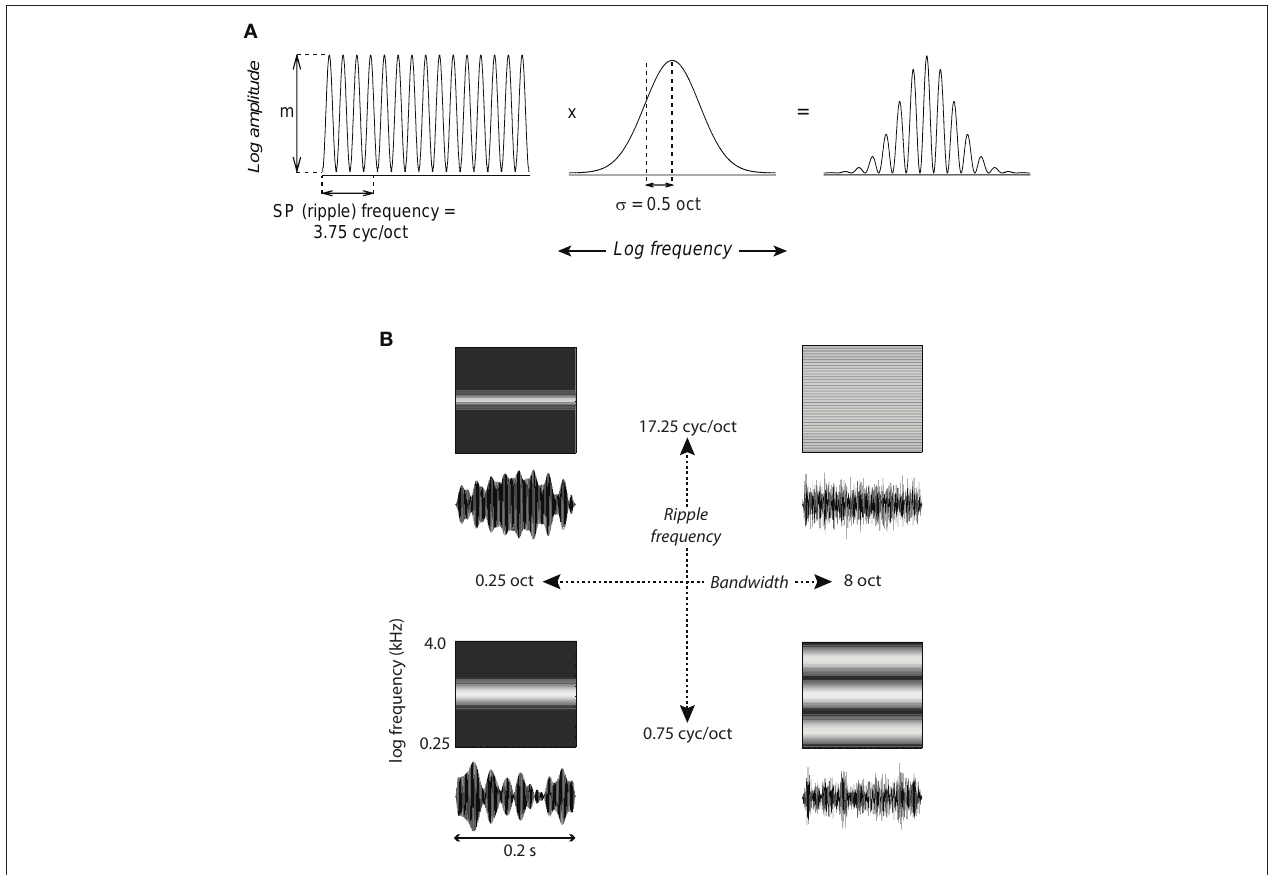
FiGure 1 | Spectral Gabor stimuli. (A) The stimulus spectrum was shaped by multiplying a 4-octave, sine-profile (ripple) spectrum ( left ), comprising 1024 pure-tone components at equal log-frequency intervals having randomized phases, by a Gaussian window ( center ). The resulting spectrum is on the right . The stimulus shown has a ripple frequency of 3.75 cyc/oct and bandwidth